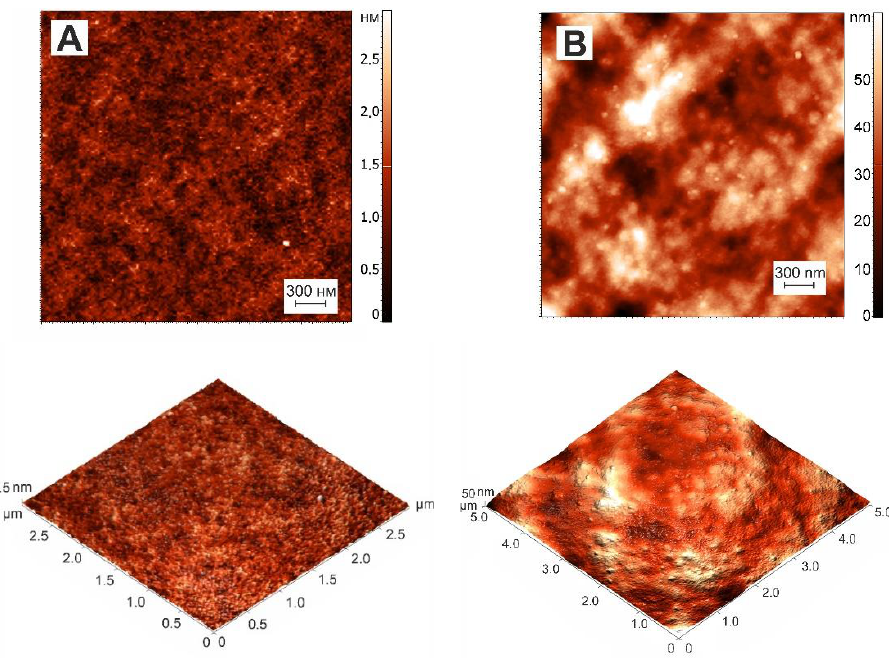
Figure 6. AFM pictures of xerogel (dried hydrogel) films and corresponding 3D surface of gelatin ( A ) and κ -carrageenan – gelatin ( B ) systems.